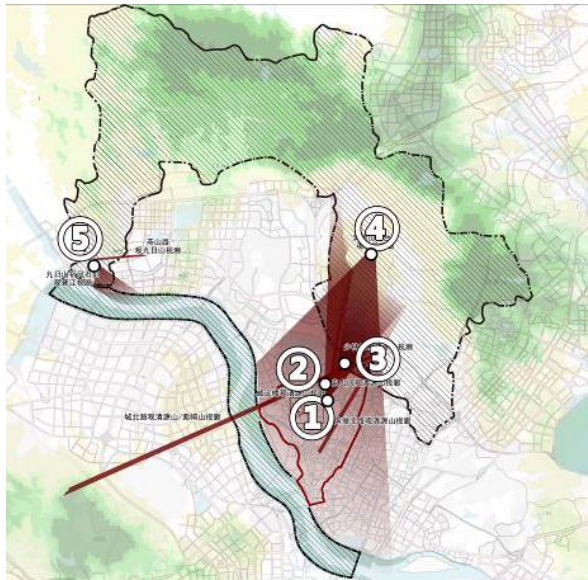
Figure 7. Range of the visual corridor No. Visual Corridors Viewing from the second floor on ① From Weiyuan Weiyuan House, drawing tangent House lines cutting the edge of the trees as viewing shown in the survey photo and the Qinyuan 230-meter contour line of Qinyuan Mountain mountain The range of the visual corridor is set by the projection of the three 3D lines onto the plane. (about 1/3 of the mountain body is in sight)